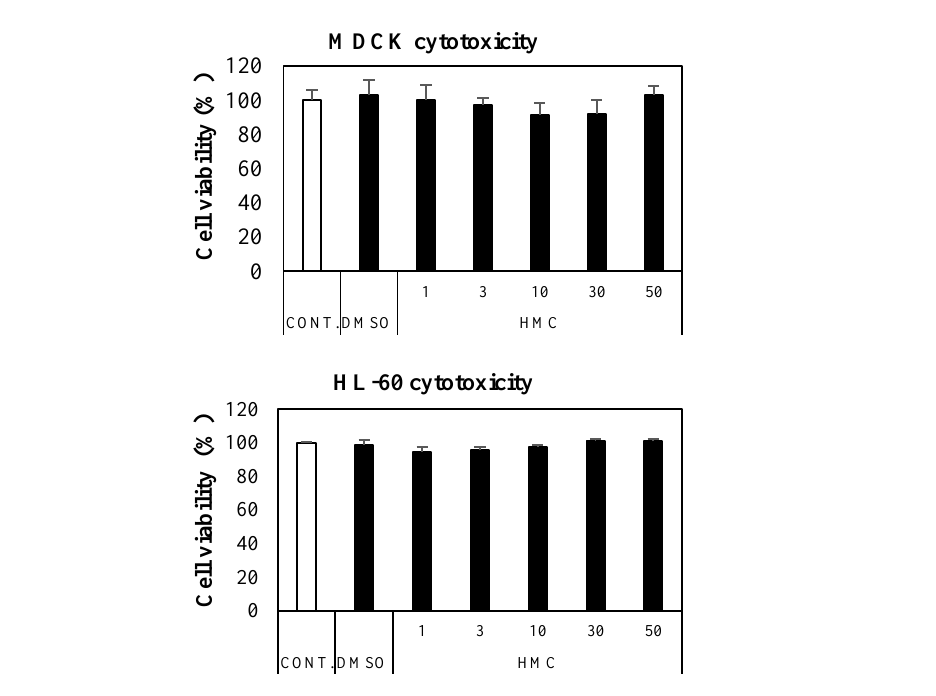
Figure 6. Cytotoxicity of HMC for MDCK (a normal cell line) and HL-60 (a Cancer cell line). The cells were treated with HMC (1, 3, 10, 30 and 50 µM) for 24 h. The culture supernatant was removed, and cell counting kit-8 was added. All data are expressed as mean ± standard deviation (SD) of triplicate independent experiments.